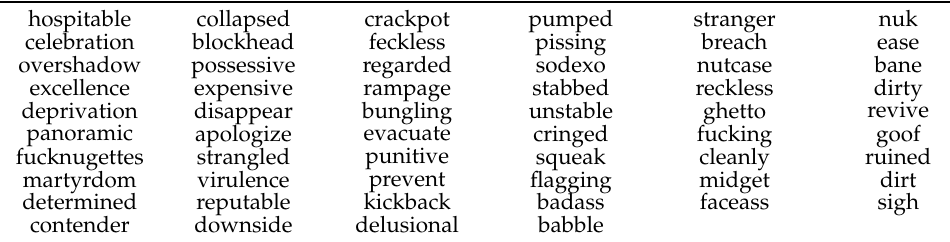
Table 6. Cluster of “Coronavirus”, 16–31 March 2020.